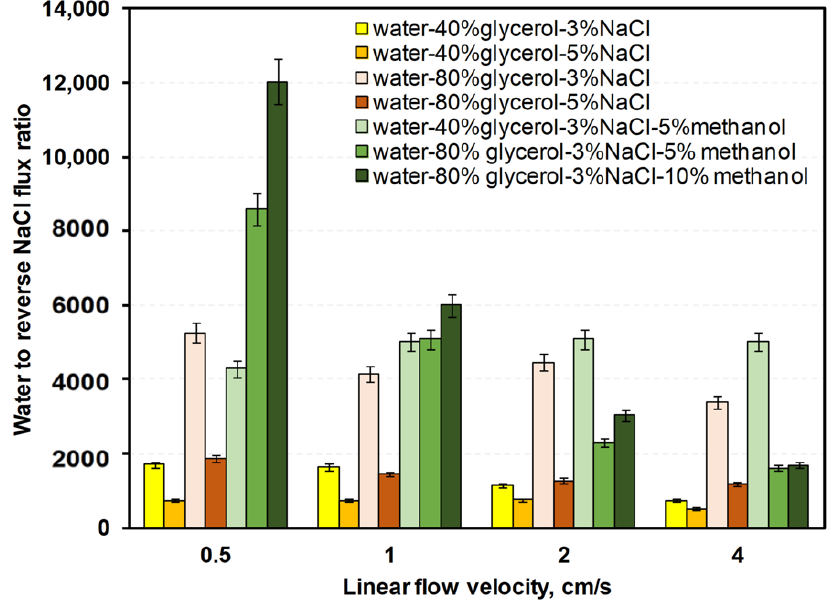
Figure 9. Water-to-reverse NaCl mass flux ratios for various linear flow velocities in counter-current FO with different water–glycerol–salt–methanol draw solutions.